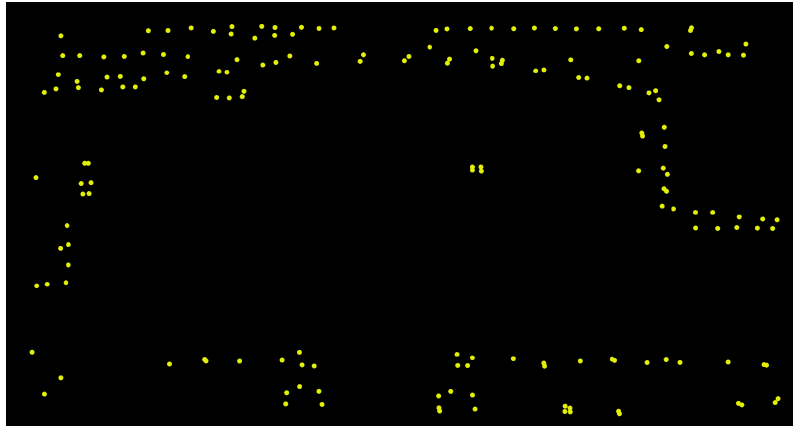
Figure 3. Down-sampled obstacle